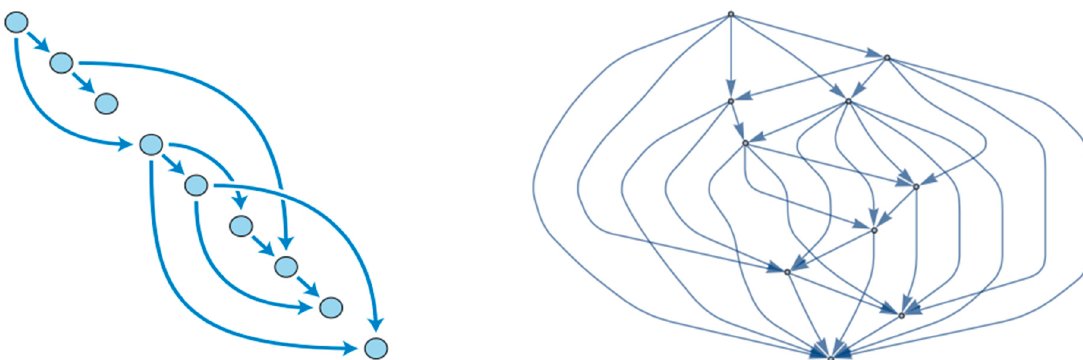
Figure 1. Two Directed Acyclic Graphs (DAGs) of connected research stages. The ordering is chronological (top-bottom) and therefore modules that are situated below one another cannot refer upwards. The left panel shows a less complex network of modules; the right panel shows a more extensive network of modules.